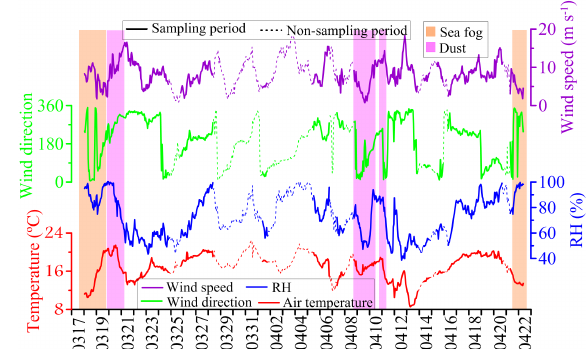
Figure 1. Map of the cruise track. Orange, pink and blue indicate sea fog, dust and background days during the cruise, respectively. Sample number and the collection range are shown.